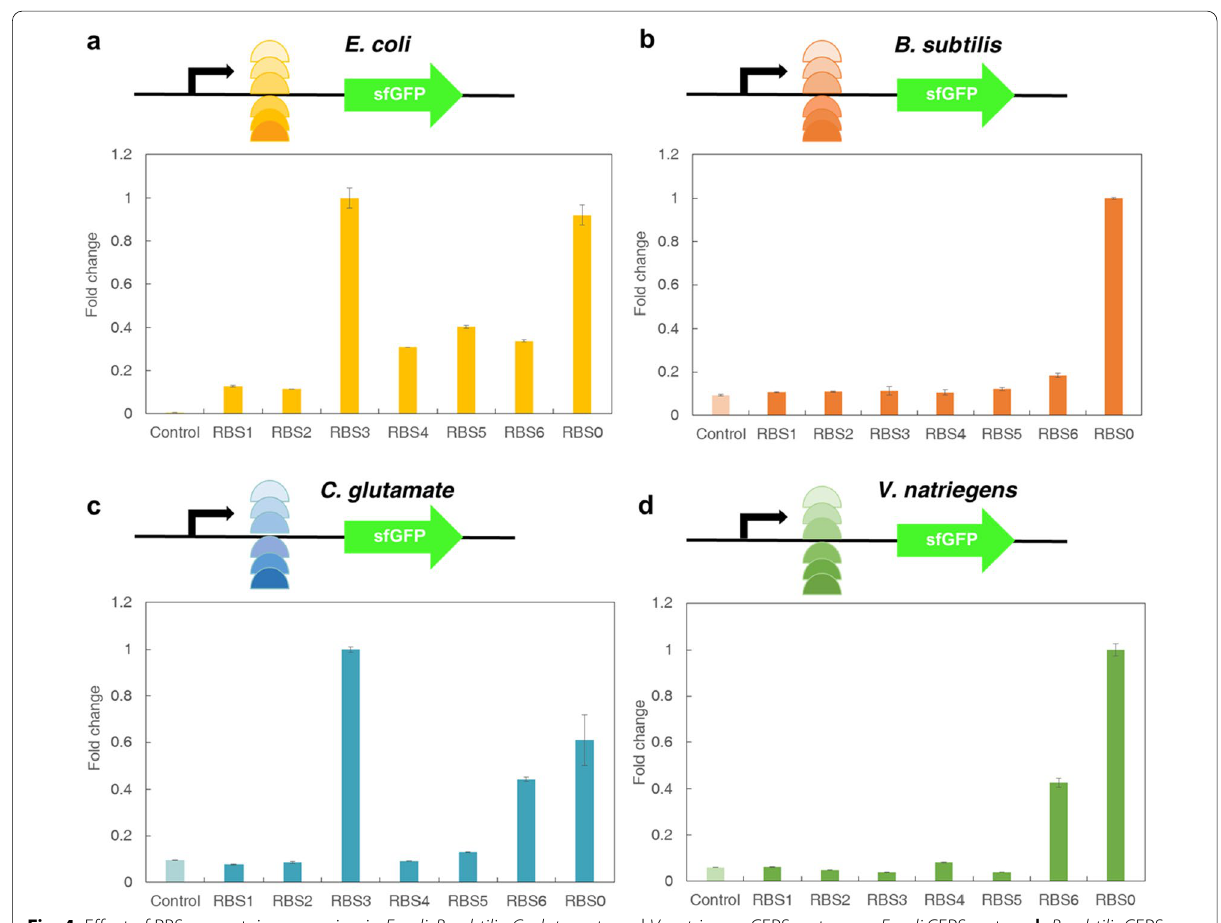
Fig. 4 Effect of RBS on protein expression in E. coli , B. subtilis , C. glutamate and V. natriegens CFPS systems. a E. coli CFPS system. b B. subtilis CFPS system. c C. glutamate CFPS system. d V. natriegens CFPS system. The control is the background value of the systems, and the mean and standard deviations are shown (N 3). The number "1" of the normalized treatment represented the optimal fluorescence value of each factor in each CFPS =